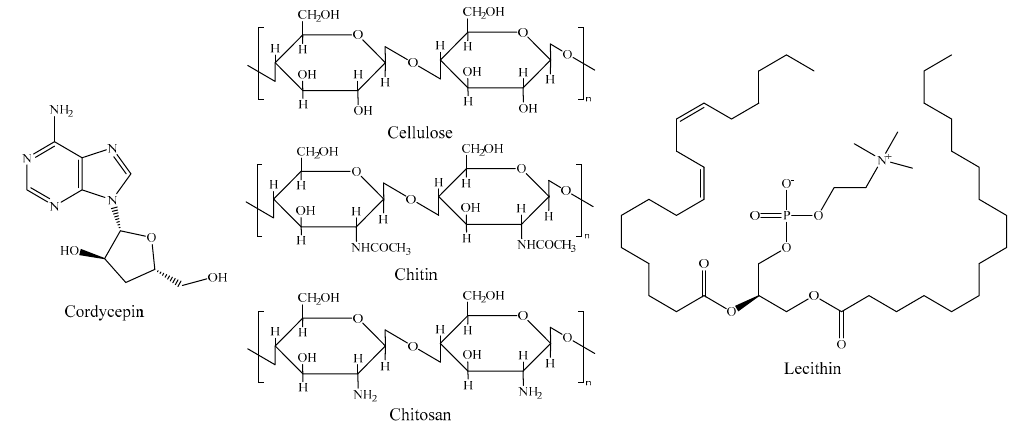
Figure 3. Structure of cordycepin, cellulose, chitin, chitosan, and lecithin [85,90].